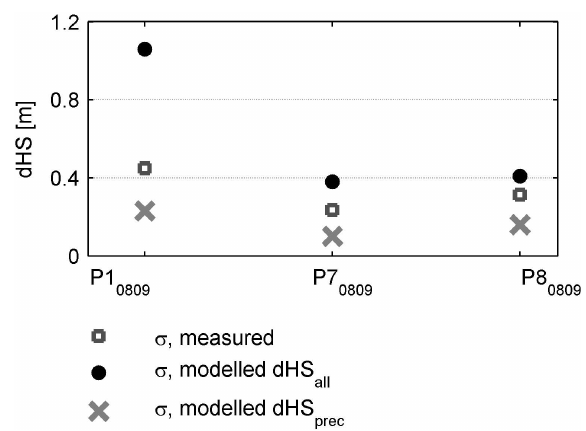
Fig. 12. Standard deviation of measured and modeled changes in snow depth (scanned area). Simulations were run with either all wind-induced snow-transport processes (dHS all ) or with preferen- tial deposition of precipitation (dHS prec )